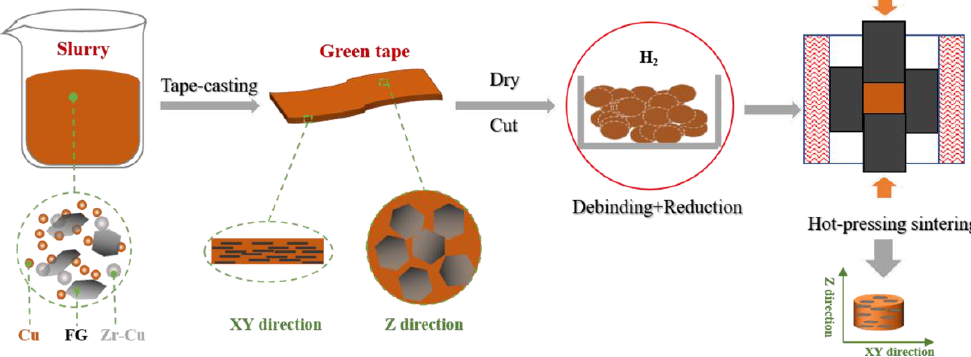
Figure 3. Schematic diagram of the preparation process of flake graphite (FG)/Cu-Zr